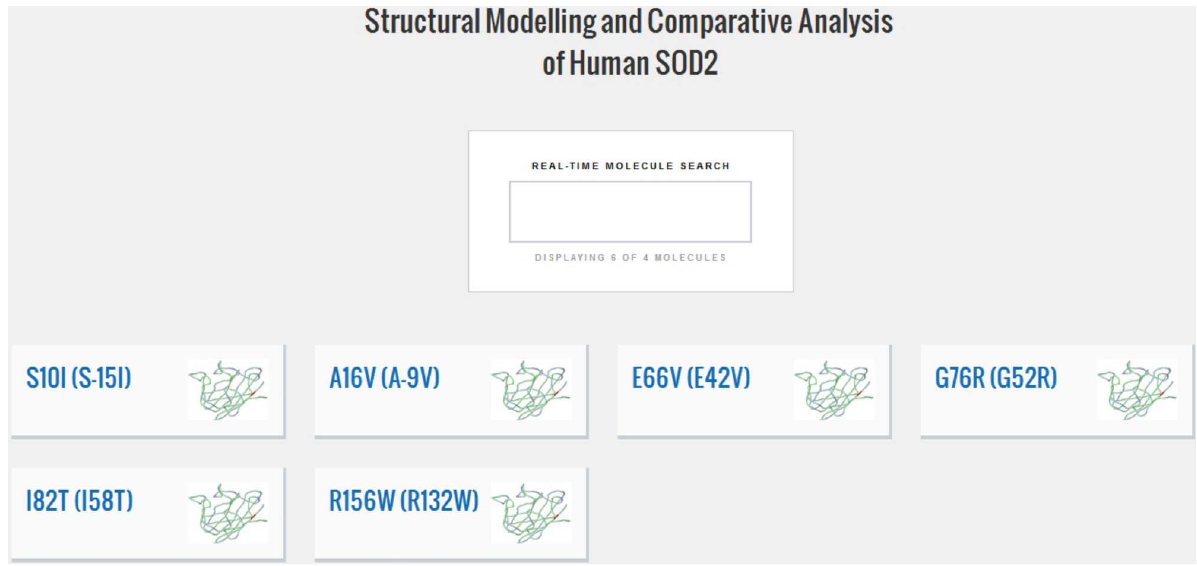
Figure 6. Screenshot of the SOD2 Database web interface for structural modelling and comparative analysis.